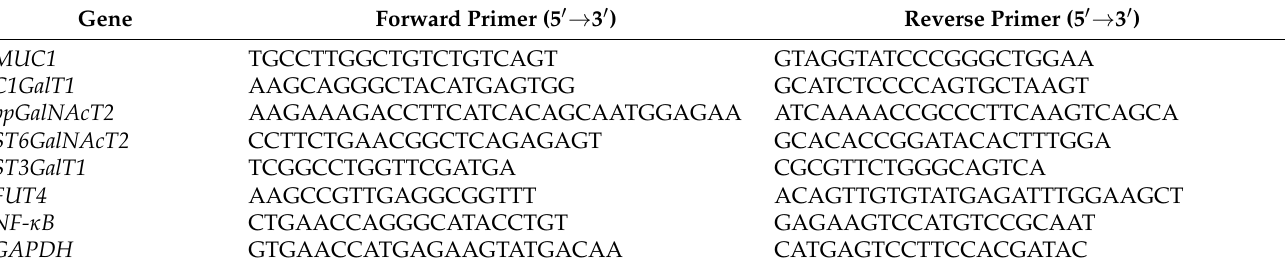
Table 2. Primers used for